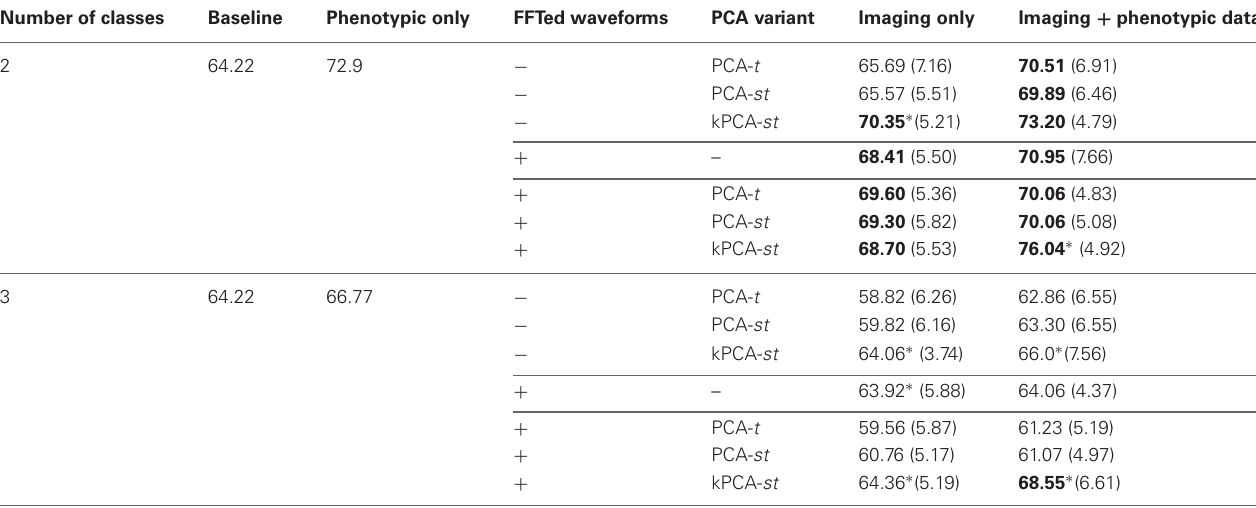
Table 2 | Two and three class classification accuracies on the original 668 subject dataset . Number of